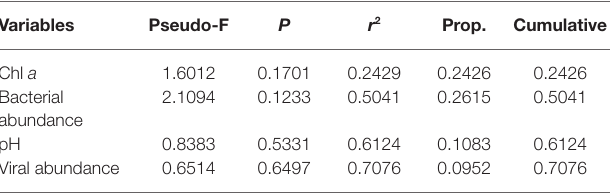
The response variables were transformed in log (X + 1) and then converted into Euclidian distance similarities matrices. The Pseudo-F and the values of p were obtained by permutation (n =